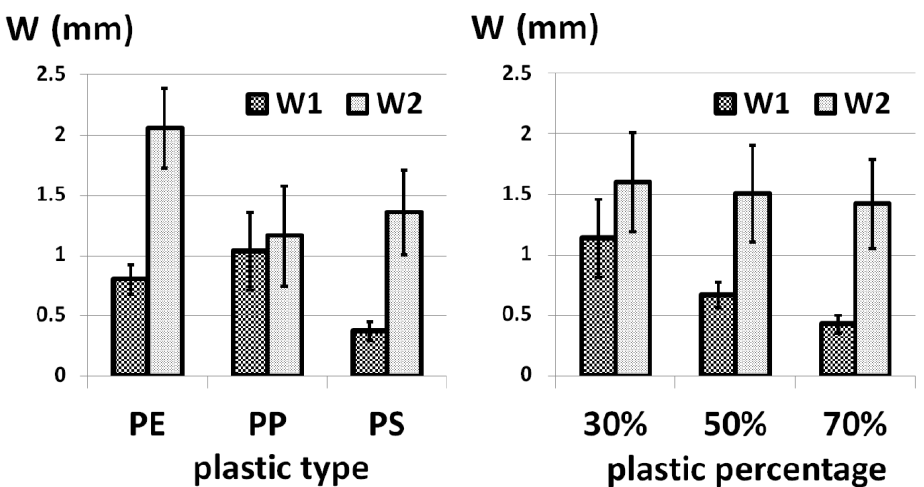
Figure 6. The effect of the plastic type and the wood – plastic ratio on the quality of the holes, which were analyzed on both sides of the boards ( W 1 [mm] and W 2 [mm] are the maximum widths of the damage zones visible around the hole on the drill entry side and the drill exit side, respectively). Table 4. The results of using ANOVA to verify the statistical significance of the impact of plastic type and plastic percentage on the maximum width of the damage zone on the drill entry side (W1 (mm)).